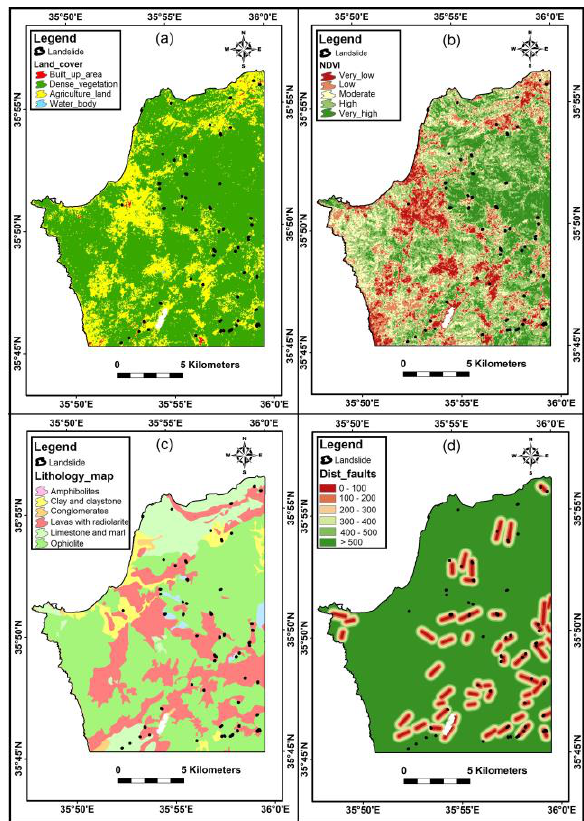
Figure 10. The causative factors maps extracted from optical remote sensing and geological data. a- Land cover. b- NDVI. c- Lithology. d- Distance from faults.